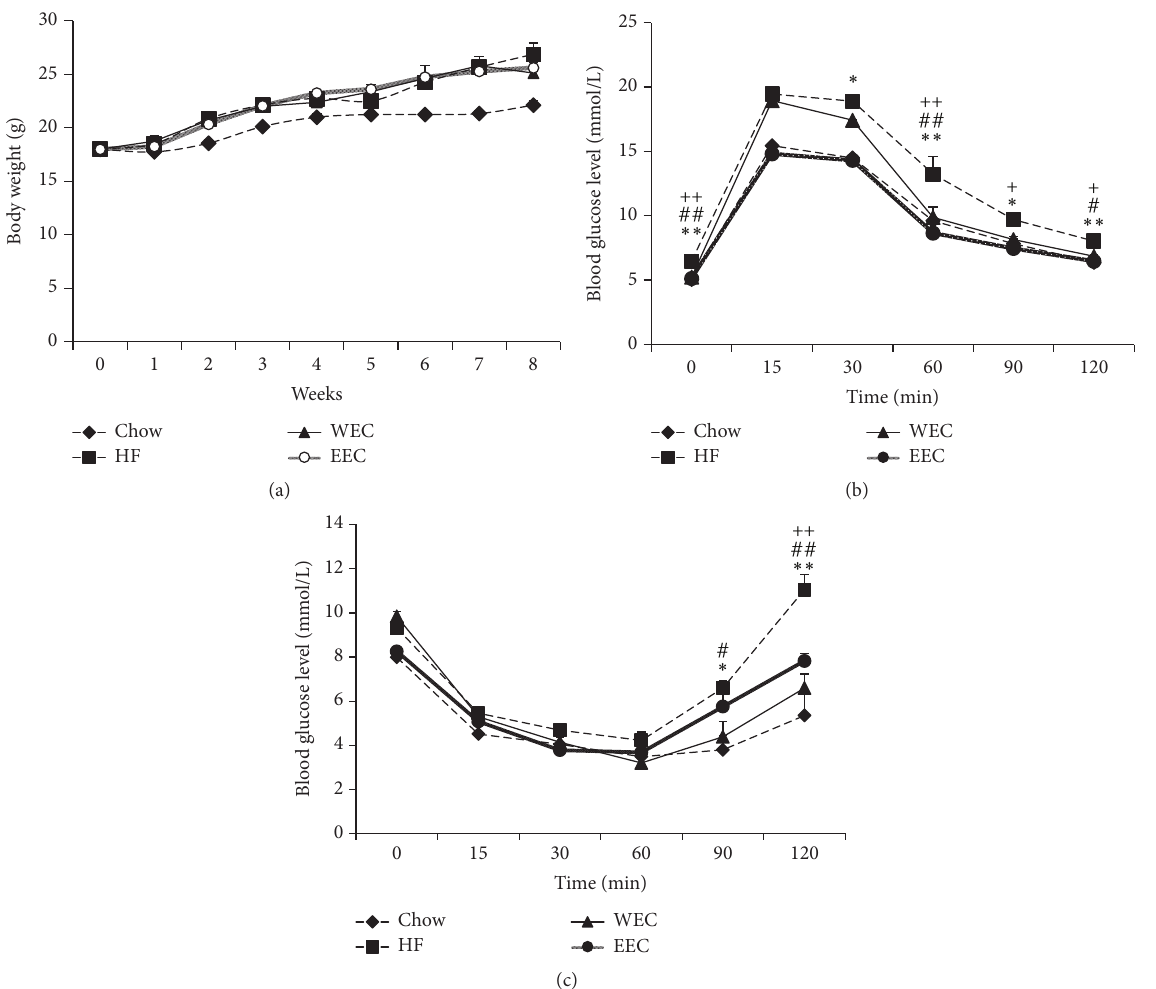
Figure 2: EEC and WEC prevent metabolic disorders included in C57BL/6 mice by a high-fat diet. (a) Body weight. (b) Intraperitoneal glucose tolerance test. The mice were fasted for 12 hours, and the fasting blood glucose was measured, and then 1g glucose/1kg body weight was given by intraperitoneal injection. And the blood glucose levels at 15, 30, 60, 90, and 120 min were tested. (c) Intraperitoneal insulin tolerance test. The blood glucose level was tested at 0, 15, 30, 60, 90, and 120 min following the intraperitoneal injection of insulin (0.75 U/kg body weight). The data are expressed as mean ± SEM. 𝑁 = 7 for all groups, Repeated measurement, SPSS 21.0. ∗ 𝑃 < 0.05 , ∗∗ 𝑃 < 0.01 : the Chow group versus the HF group; # 𝑃 < 0.05 , ## 𝑃 < 0.01 : the WEC group versus the HF group; + 𝑃 < 0.05 , ++ 𝑃 < 0.01 : the EEC group versus the HF